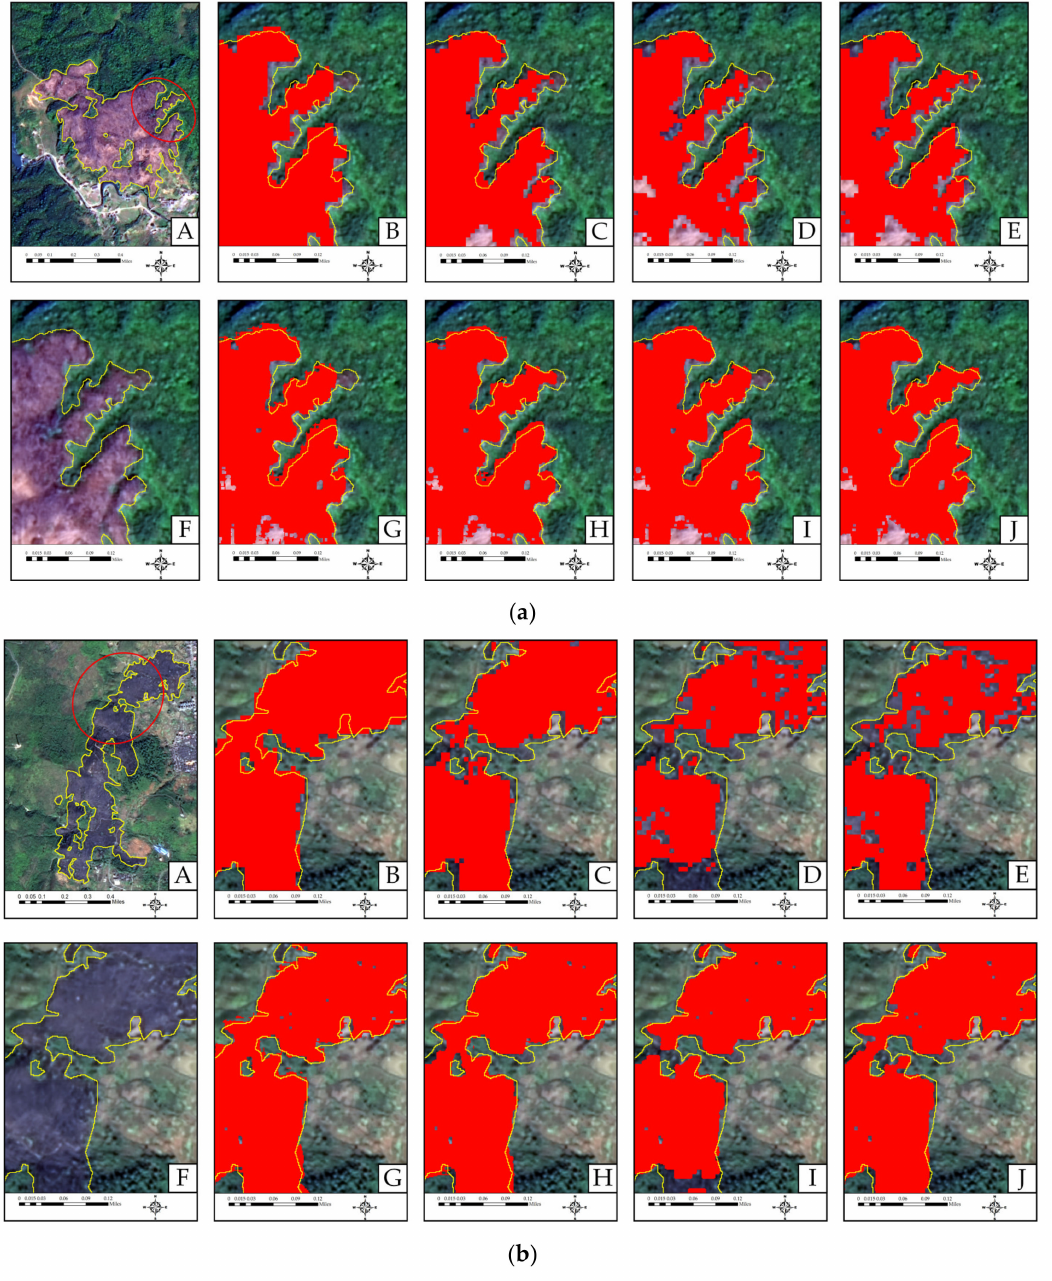
Figure 5. Comparison of the burned area mapped at subpixel level with that mapped at pixel level using different algorithms at the fire-scar site in 7CSNX ( a ), 8CZGY ( b ). The yellow polygon of panels ( A – J ) are the fire-scar site vector data. Panels ( B – J ) are zoomed view of the red circle in Panel ( A ). Panels ( B – E ) are the burned area mapped at pixel level, where red area represents burned area